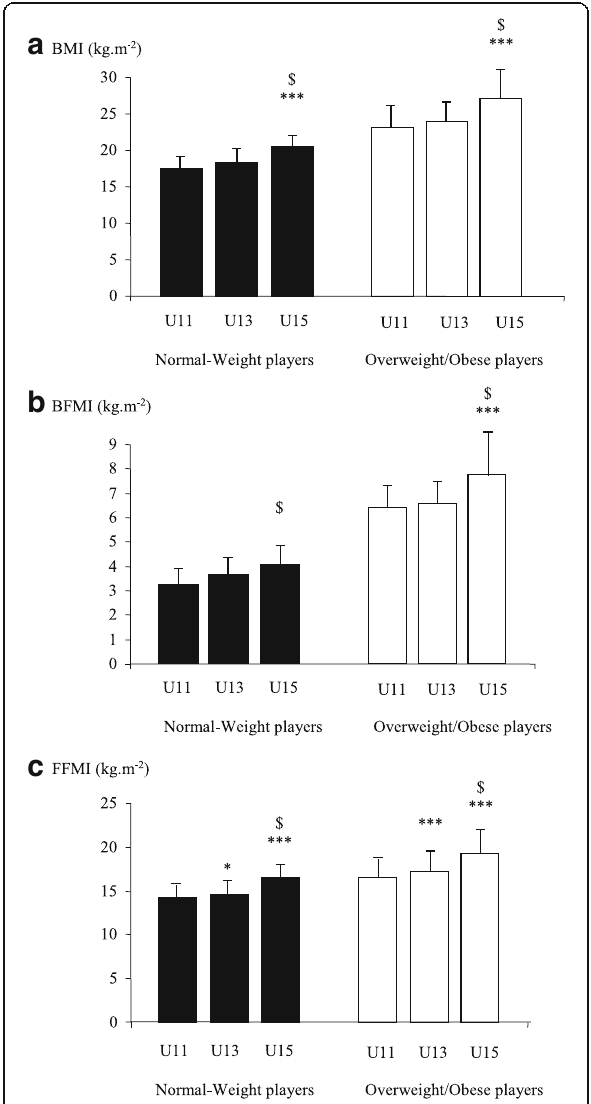
Fig. 1 Changes in body mass index (BMI), body fat mass index (BFMI),